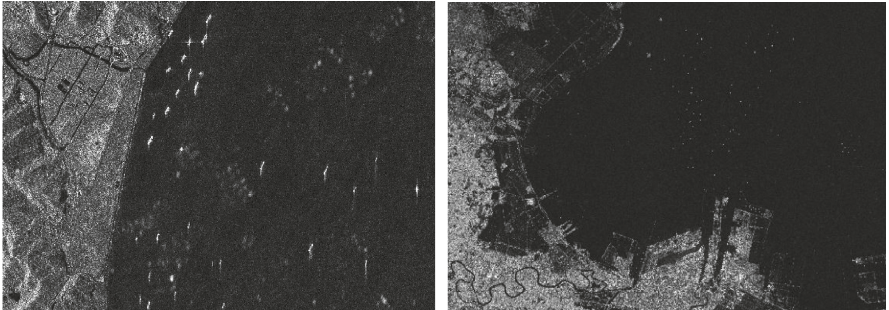
Figure 4: Two images in our ship detection